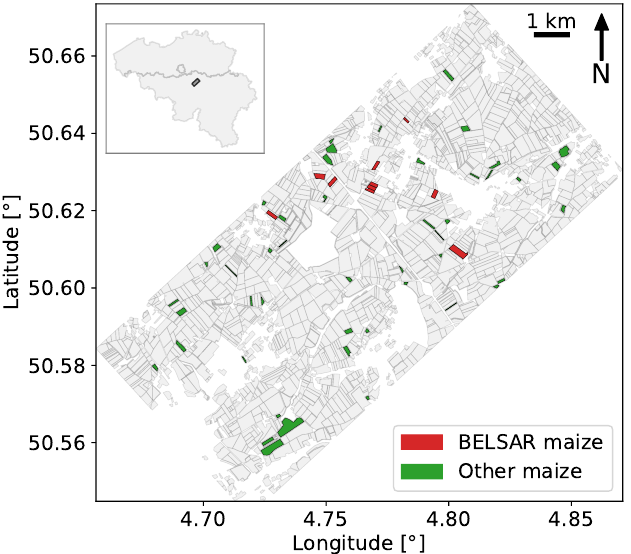
Figure 1. BELSAR area of interest, with the maize fields in which in-situ measurements were collected in red, the other maize fields in the area in green, and all the remaining agricultural fields inventoried as delineated in the Land Parcel Information System of Wallonia, Belgium, in